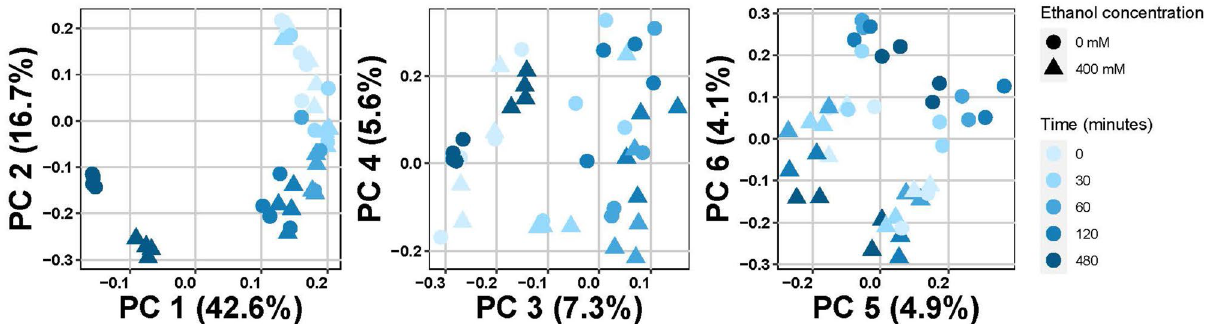
Figure 1. Principal component analysis. We identified six principal components contributing to the variation in the transcriptional responses in our assays (> 4% of variance). The colors indicate the time of 0 mM or 400 mM ethanol exposure (darker colors are longer exposure times). Circles: 0 mM ethanol exposed; Triangles: 400 mM ethanol exposed. The different principal components are depicted on the x- and